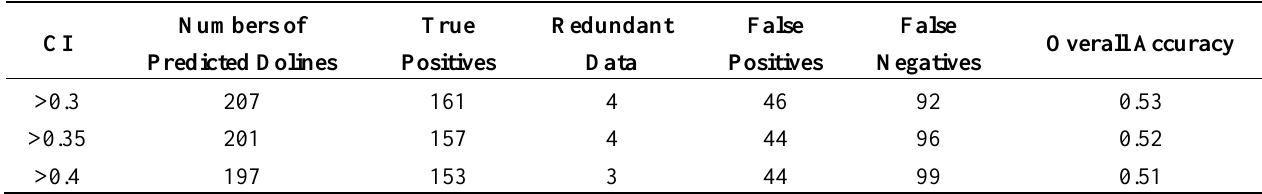
Table 8. Predicted dolines using ALOS/PRISM-DEM and circularity index attribute for dolines depth > 2 m and area > 13,125 m 2 . The comparison is made with true dolines (249) obtained by visual interpretation.